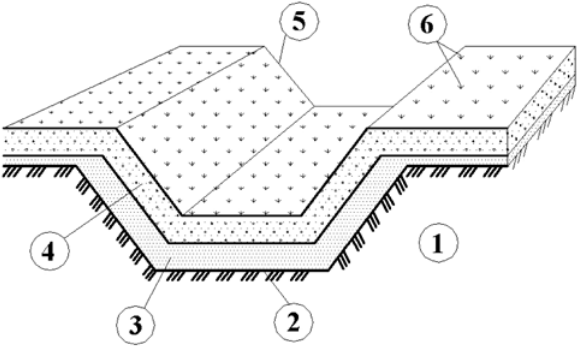
fig. 4. Scheme of infiltration-grassy